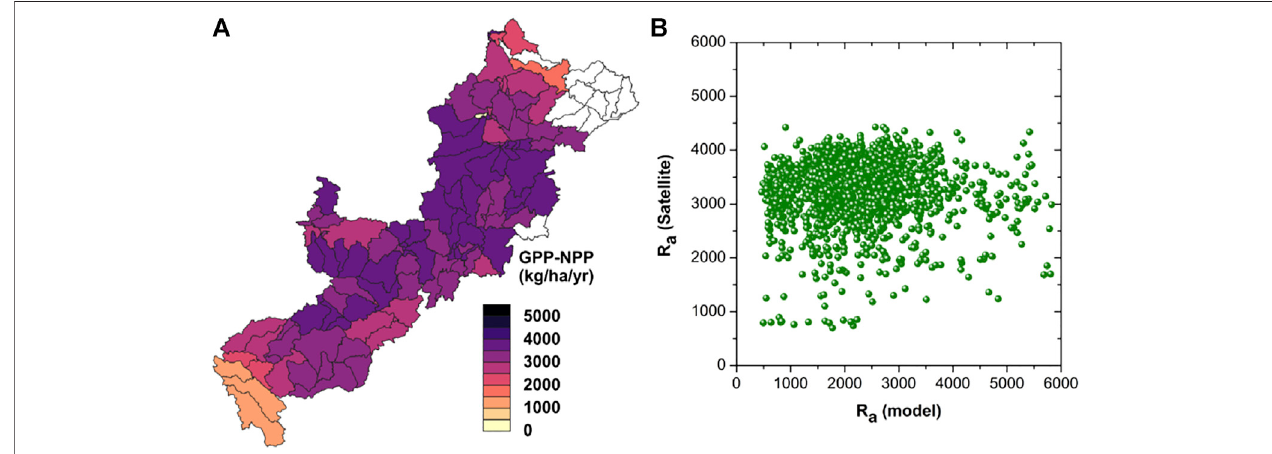
FIGURE 4 | (A) Mean annual total autotrophic respiration (root and above ground biomass) from satellite-based estimates [R a (Satellite)] in 2000 – 2013. (B) Relationship between autotrophic respirations from satellite and modeled estimates in kg C ha − 1 yr − 1 at ARB during 2000 –